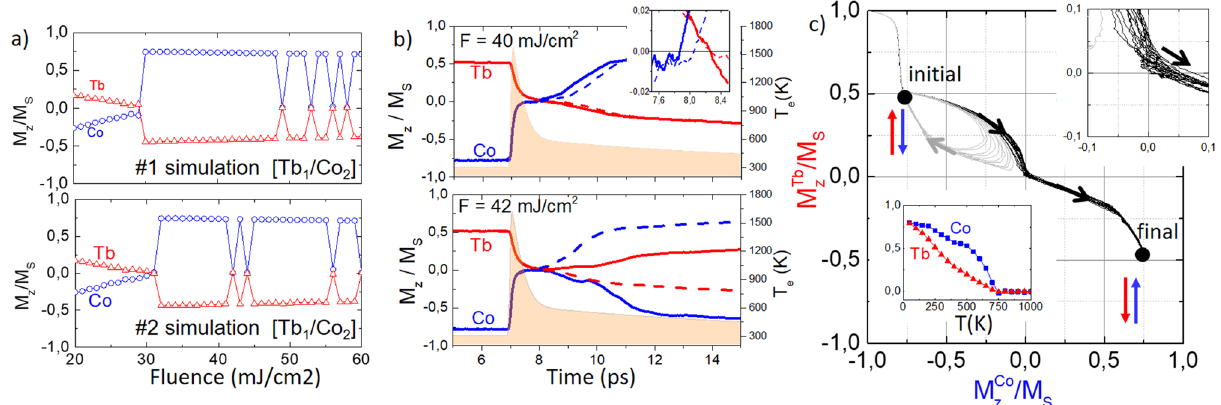
Figure 3. ( a ) Normalized magnetization of Tb and Co as a function of the laser fluence. M z / M s ratios were extracted from the magnetization curves of two different simulations of the [ Tb 1 / Co 2 ] system. ( b ) Time evolution of the magnetization of Tb and Co sublattices, M Co (blue) and M Tb (red), after the application of a single laser pulse at t = 7 ps in the system [ Tb 1 / Co 2 ] for two different fluences: 40 mJ/ cm 2 (top) and 42 mJ/ cm 2 (bottom). The two different events for each fluence value are represented by the solid and dashed lines. Inset: M Z / M S during 7.6 < t < 8.4 ps. Evolution of the electronic temperature after the single laser pulse interacts with the system at t = 7 ps (pink background). The single laser pulse duration is 50 fs. ( c ) Magnetization of Tb and Co sublattices in a magnetization phase map. Upper inset: Pathways followed by the magnetizations in a vicinity of zero. The magnetic moment of the Co sublattice always crosses zero before the magnetic moment of the Tb sublattice. Lower inset: Magnetization of the sublattices as a function of the temperature. The effective Curie temperature of the system is close to 750